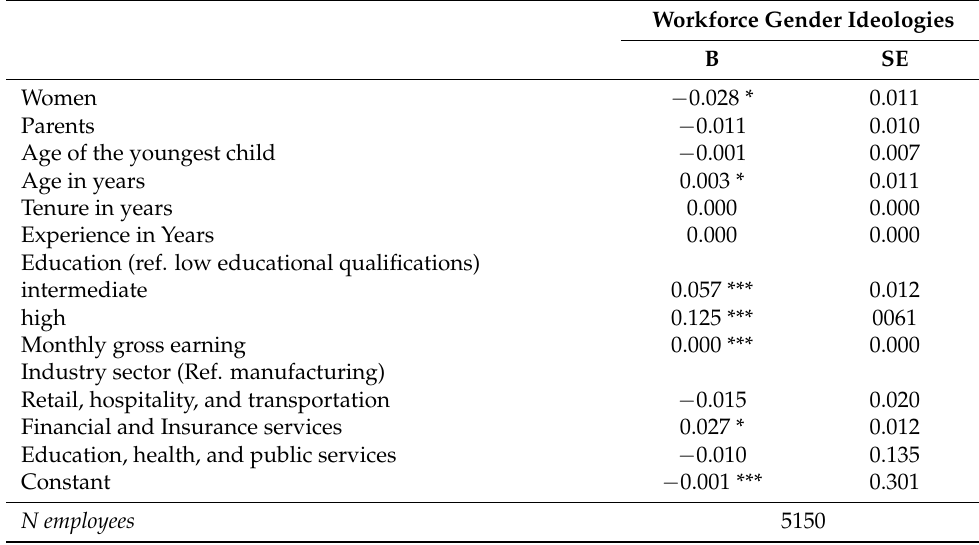
Table A1. Results of logistic regression models on the probability to have participated in the LEEP-B3 follow-up survey (average marginal effects).